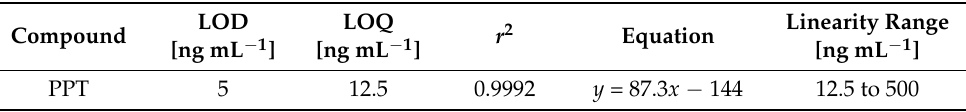
Table 3. Analytical parameters of the LC-MS/MS quantitative method and data for calibration curves for the determination of the podophyllotoxin (PPT) concentration.